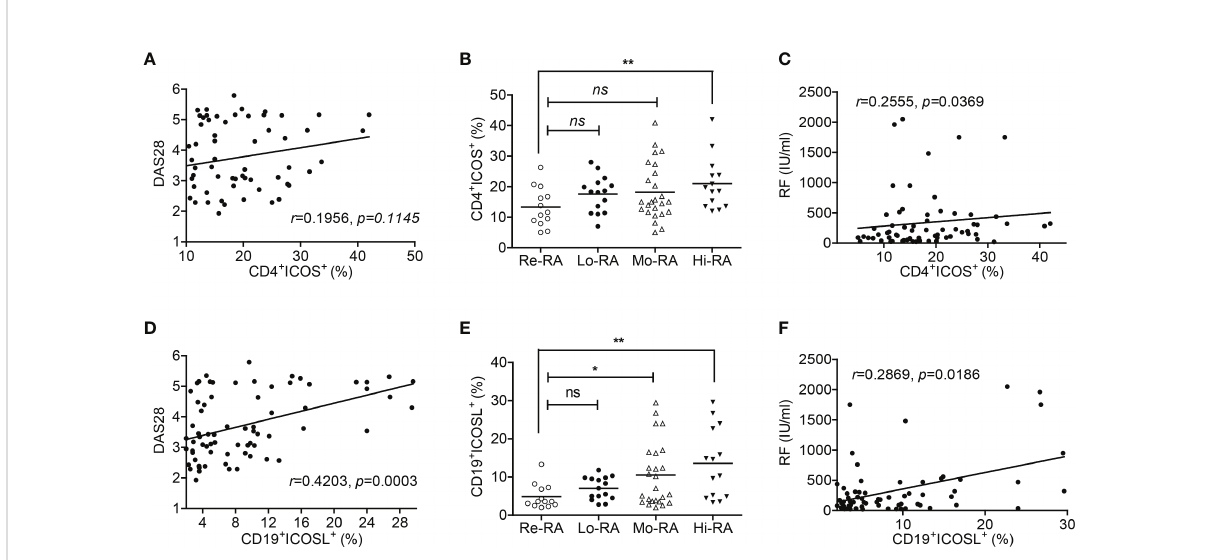
FIGURE 2 Correlations between CD19 + ICOSL + B cells and clinicopathological characteristics of patients with RA. (A) Correlation between the percentage of CD4 + ICOS + T cells and DAS28 in patients with RA (n = 67). (B) The populations of CD4 + ICOS + T cells in patients with Re-RA (n = 13), Lo-RA (n = 15), Mo-RA (n = 25) and Hi-RA (n = 14). (C) The percentage of CD4 + ICOS + T cells and RF in patients with RA (n = 67). (D) Correlation between the percentage of CD19 + ICOSL + B cells and DAS28 in patients with RA (n = 71). (E) The populations of CD19 + ICOSL + B cells in patients with Re-RA (n = 13), Lo-RA (n = 15), Mo-RA (n = 25) and Hi-RA (n = 14). (F) The percentage of CD19 + ICOSL + B cells and RF in patients with RA (n = 67). Each data point represents an individual subject; horizontal lines represent means; the r value indicates Spearman ’ s correlation coef fi cient; * P < 0.05, ** P < 0.01, ns = not signi fi